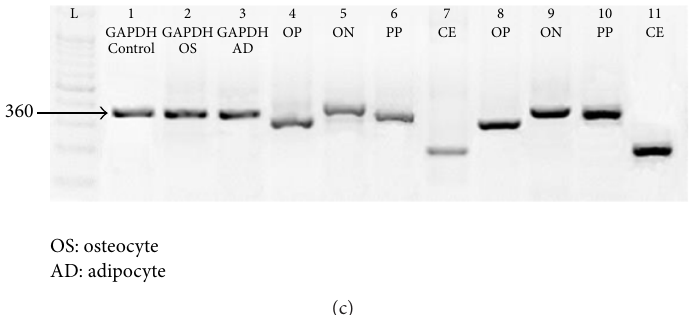
Figure 2: Characterization of rBM-MSCs. The immunophenotyping to characterize the surface markers was performed using rBM-MSC from passage 3. Cells were positively expressed as CD90.1, CD29, CD71, and CD44 and negatively expressed as CD11b/c and CD45 (a). Mesodermaldifferentiationwasconductedusingcellsofpassage3thatissubjectedtotherelevantinductionmedia.After20daysofinduction, cells were stained with Oil Red O solution and Alizarin Red solution, respectively. Adipogenic differentiation was evidence by lipid droplet formation stained with Oil Red O whereas osteogenic differentiation was evidenced by calcium deposits stained with Alizarin Red (b). Gene expression of differentiated adipocytes and osteocytes was evaluated using RT-PCR. Untreated rBM-MSC (control) showed faint expression for osteocytes (c). Results were representative of 3 experiments. OP: osteopontin, ON: osteonectin, PP: PPAR 𝛾 , and CE: C/EBPA. Microscopic magnification: 200x.